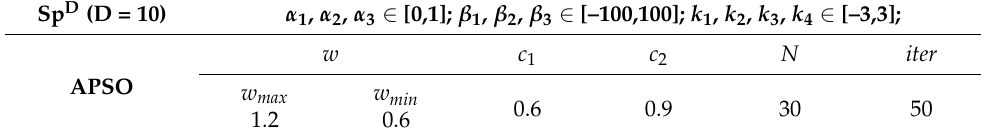
Table 1. Particle search range of reflective system.